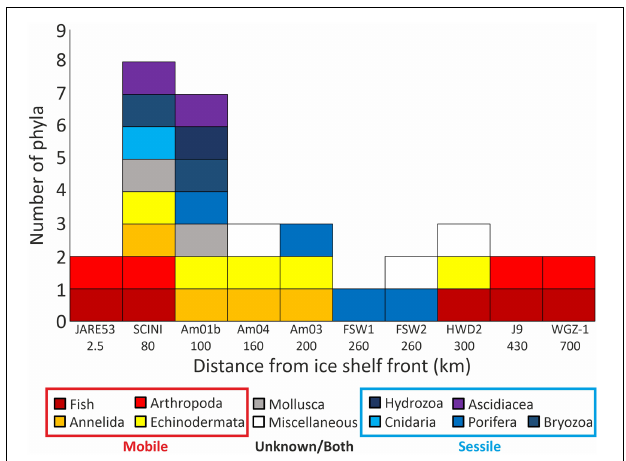
FIGURE 4 | Counts of phyla observed at each borehole with increasing distance from the ice shelf front, boreholes with no observed life are excluded. Miscellaneous, unidentifiable living organisms or evidence of infaunal